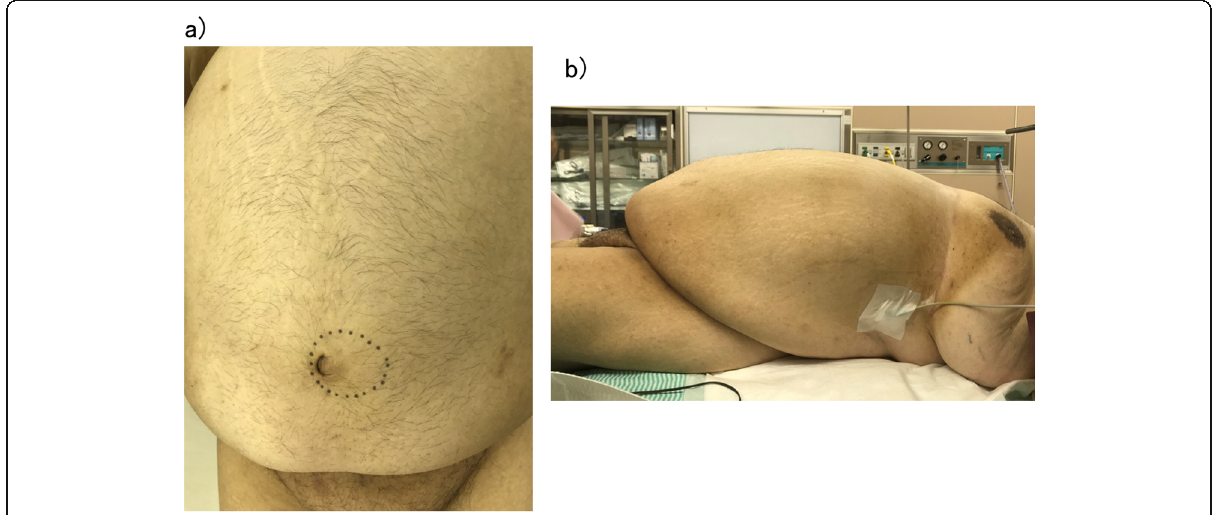
Fig. 1 Abdominal photographs. a Frontal view: a mass measuring approximately 10cm is present in the umbilical region (dotted circle). b Side